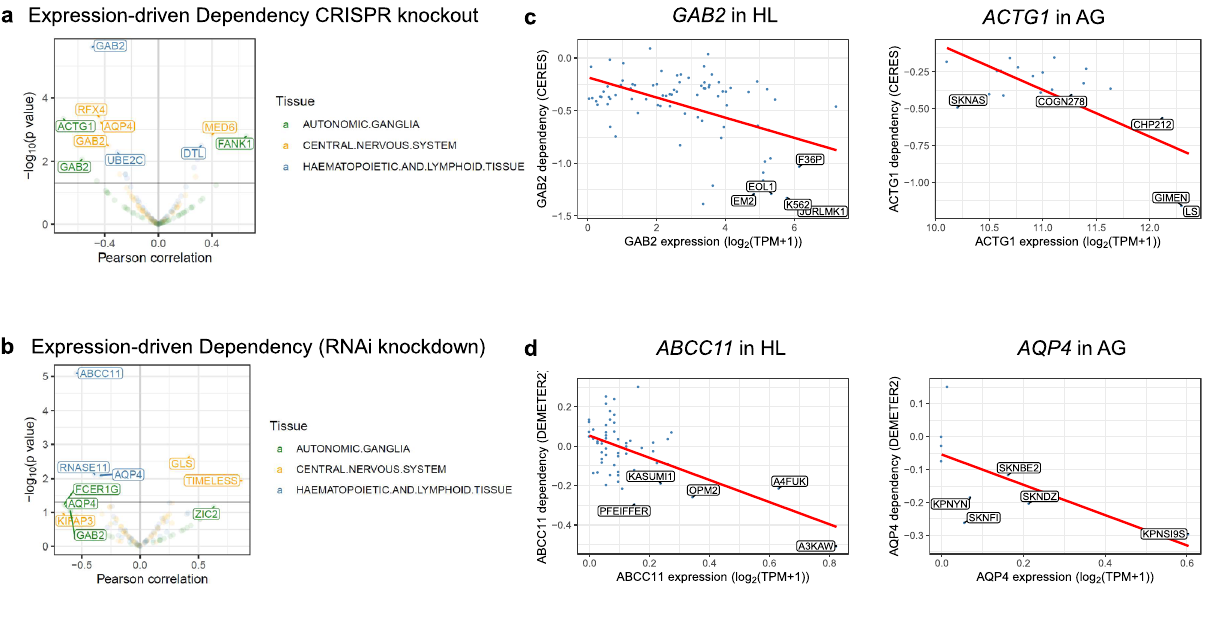
Figure 4. Expression-driven Dependency of AD Network Hub Genes. ( a ) A volcano plot showing expression- driven dependency of AD network hub genes based on CRISPR knockout screen data. ( b ) A volcano plot showing expression-driven dependency of AD network hub genes based on RNAi knockdown screen data. For ( a ) and ( b ), Pearson correlation coefficients were calculated for AD risk genes using a gene’s expression versus the dependency scores for three tissue types (color-coded) relevant to AD etiology: hematopoietic and lymphoid tissue (HL), central nervous system (CNS), and autonomic ganglia (AG). The correlation plots of the expression- driven dependency were shown for associations found for ( c ) GAB2 in HL cell lines and ACTG1 in AG cell lines against CERES scores ( d ) ABCC11 in HL cell lines and AQP4 in AG cell lines against DEMETER2 scores. The best-fitted regression lines are shown in red and the cell lines with the highest expression and dependency are further labeled in each